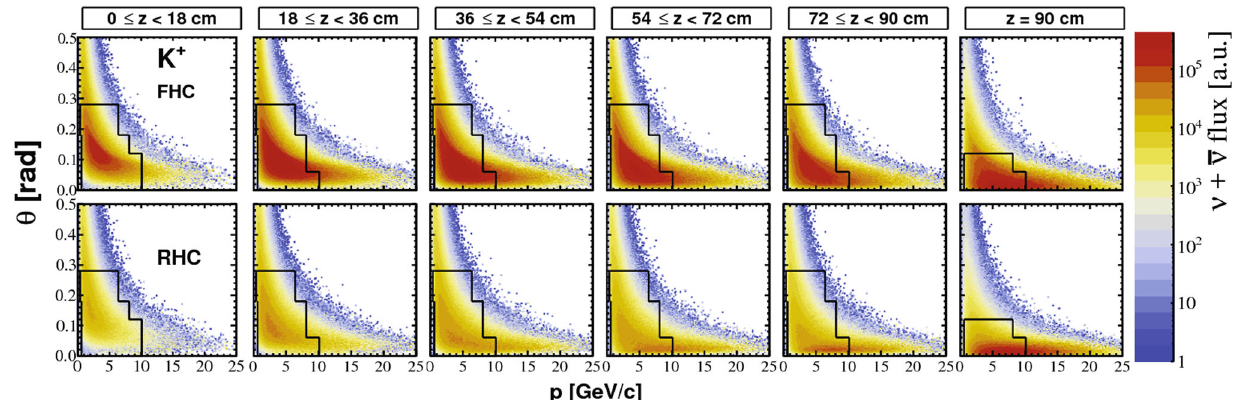
Fig. 8 The p − θ distribution of negatively charged pions emitted from the surface of the T2K target which contribute to the (anti)neutrino flux in Super-Kamiokande . The top row shows the phase space plots in the forward horn current configuration, while bottom plots show the phase